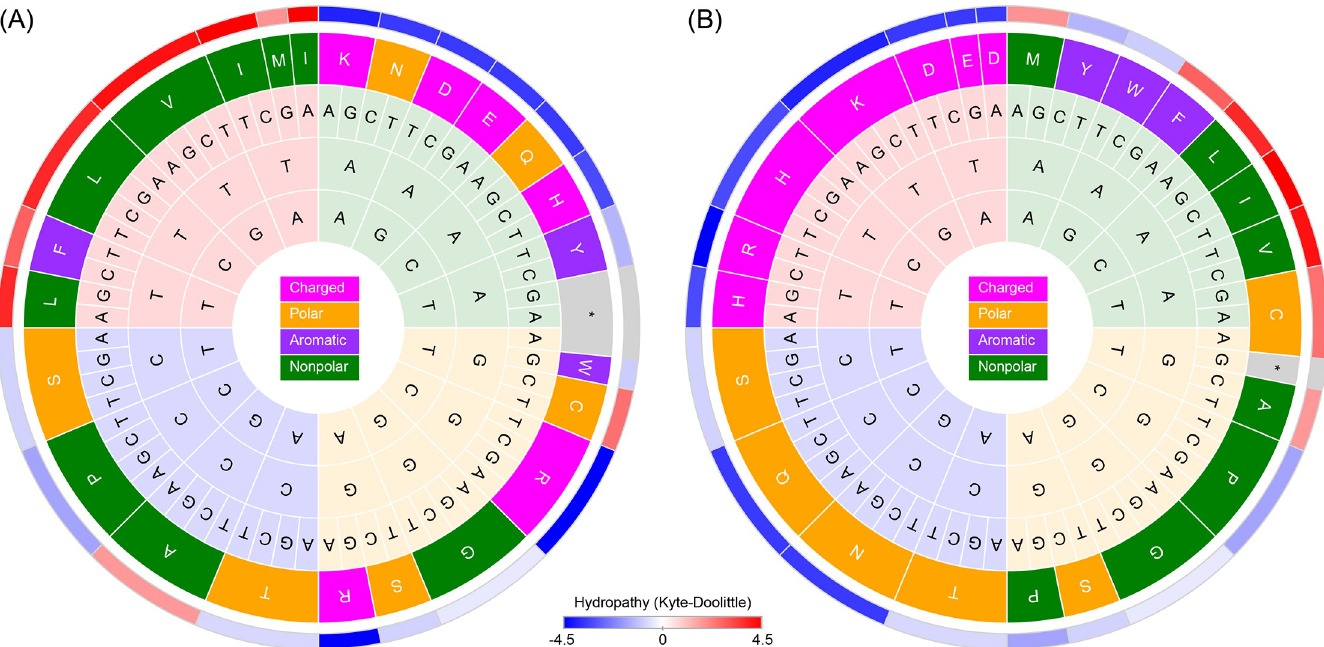
Fig 1. Codon wheels showing (A) the standard genetic code (SGC) and (B) a Hopfield-optimized genetic code. Bases are arranged (from center outward) in the order of 1 st , 2 nd , and 3 rd codon positions. Within each of these three rings, the four bases are cycled clockwise in the order of “ AGCT ” to minimize the number of transversions. The codon wheel represents the shortest mutation path and is modeled as the time dimension in the Traveling Salesman Problem (TSP) representation of the genetic codes. In the 4 th ring, amino acids are colored according to a physio-chemical classification [18]. In the 5 th ring, amino acids are colored by the Kyte- Doolittle measure of hydrophobicity